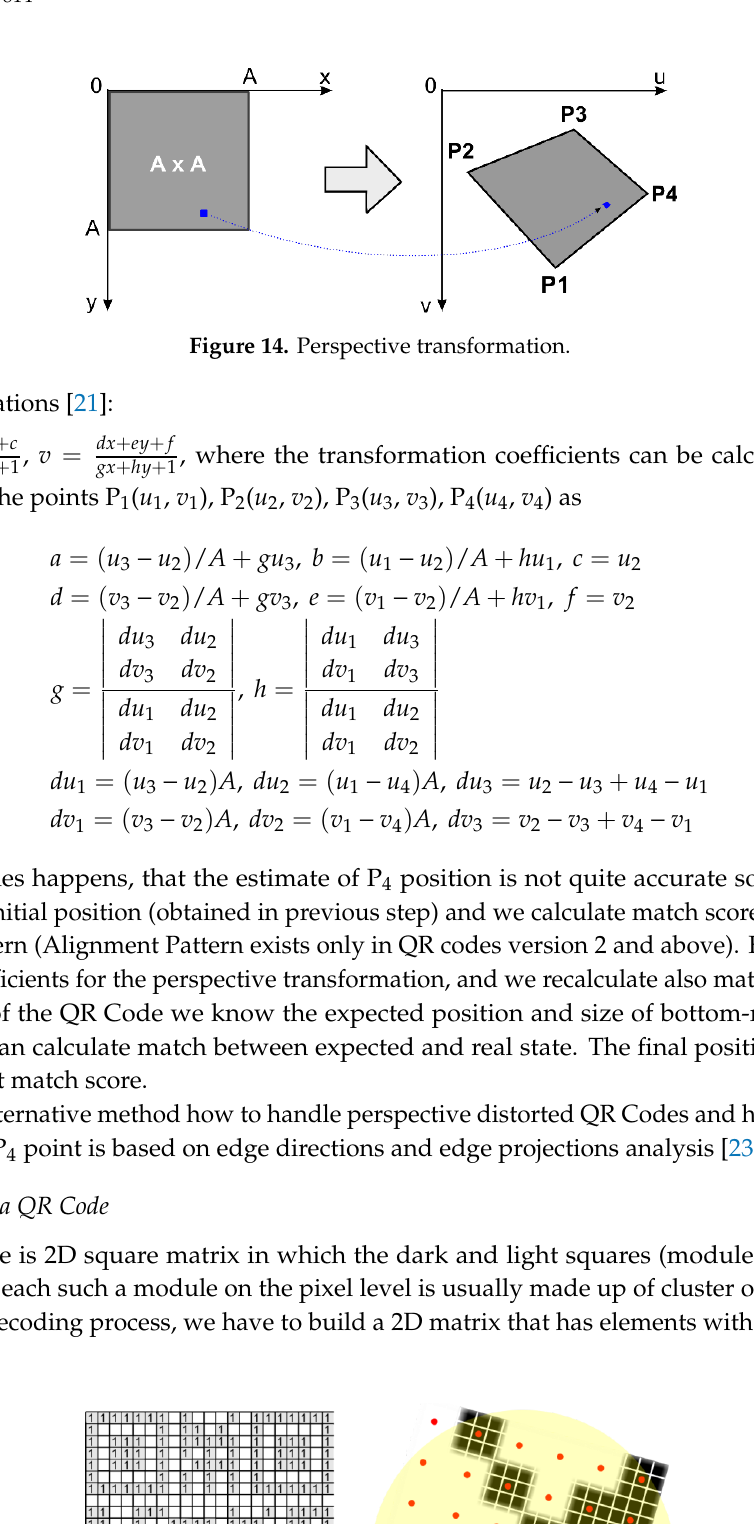
4 and lines L 1 , L 3 ; ( b ) first shift of